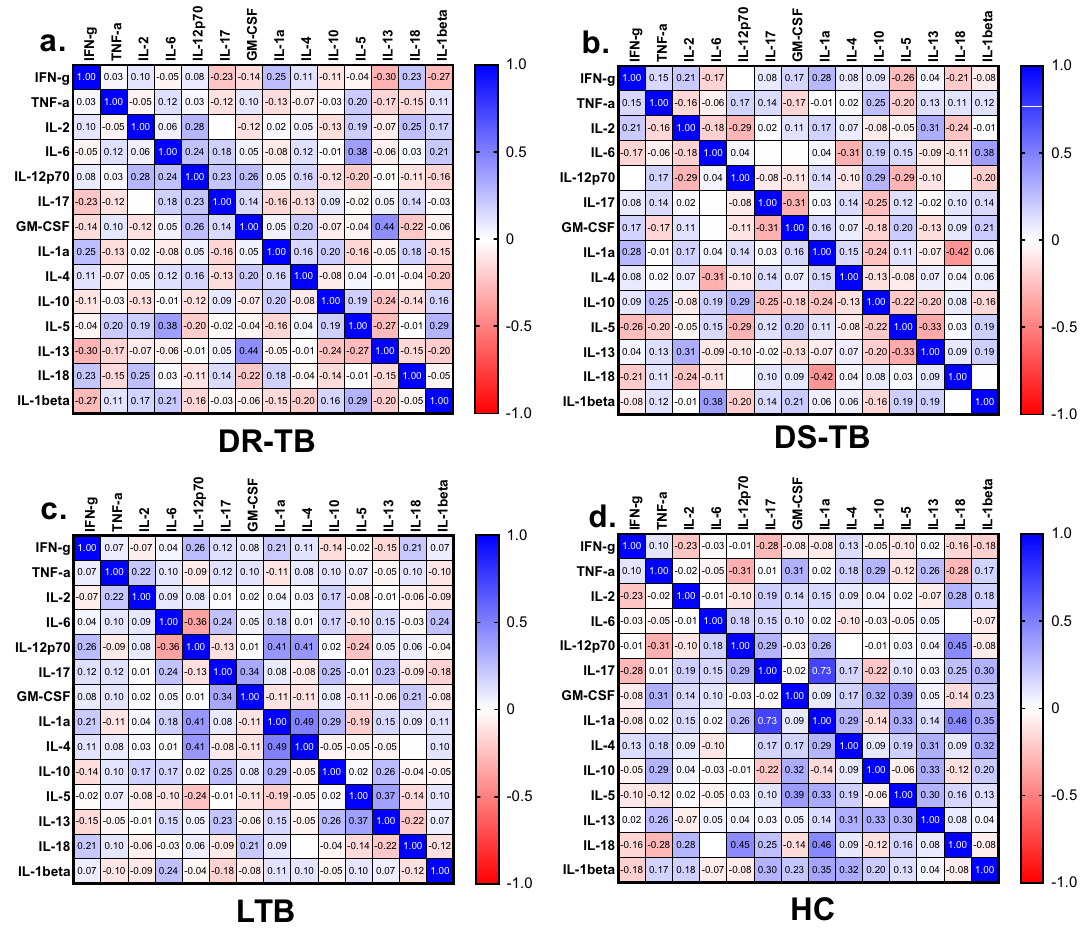
Figure 6. Correlation matrix using spearman rank correlation between the measured cytokines of the study groups, a. DR-TB, b. DS-TB, c. LTB and d.